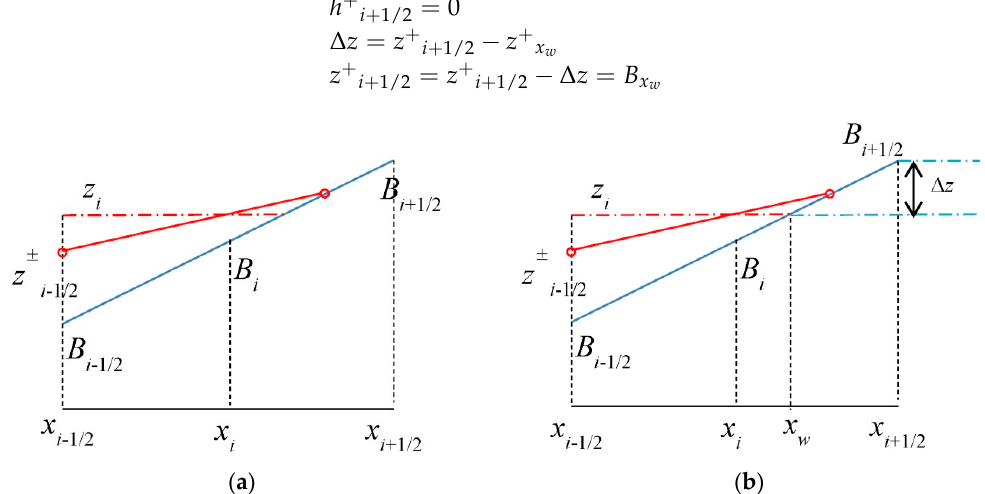
h − + for the partially flooded cell. ( a ) Without 1/2 i